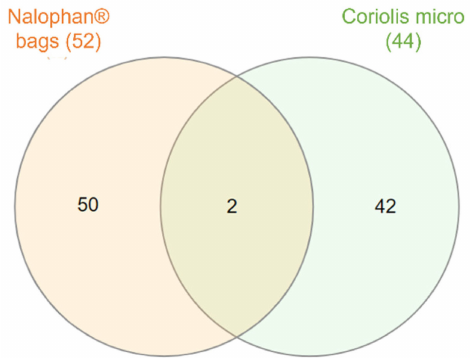
Figure 1. Distribution of molecules found using both techniques of air sampling. Venn diagram illustrating the degree of overlap of molecules found with Coriolis micro and Nalophan ® bags method. The central section in orange represents the compounds found in common between the two methods. Specific compounds found with Nalophan ® bags are in pink, whereas those found with Coriolis micro are in